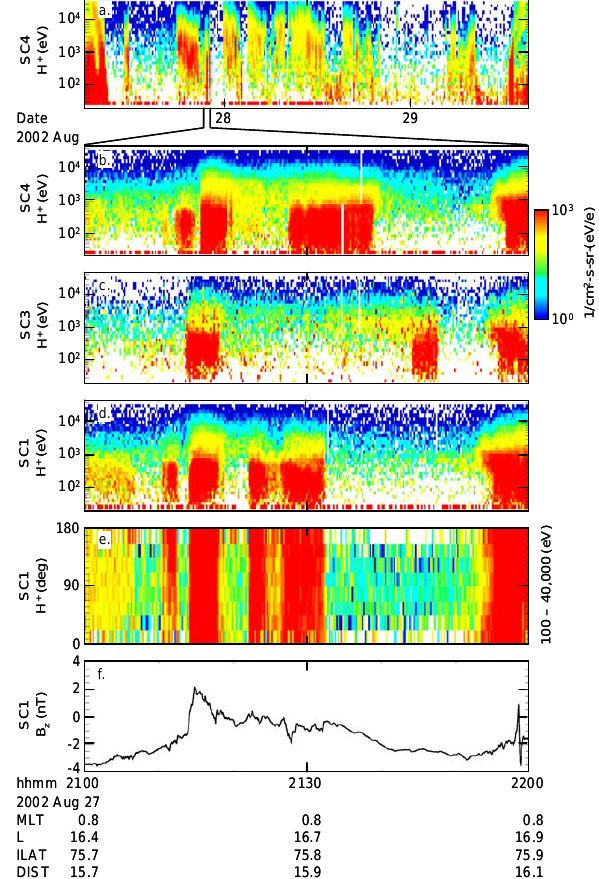
Fig. 2. (a) Spacecraft (SC) No. 4 differential proton flux, averaged over view angles (4 π ) and color coded (color bar on the right), versus time ( x axis) and energy ( y axis). (b)–(d) One-hour expanded views of flux from SC 4, 3, and 1. (e) SC 1 differential flux, averaged over energy (0.1 − 40 keV) and sorted by pitch angle. (f) GSE z component of magnetic field measured at SC 1. Ephemeris at bottom is that of SC 1 (cf. Table 1).